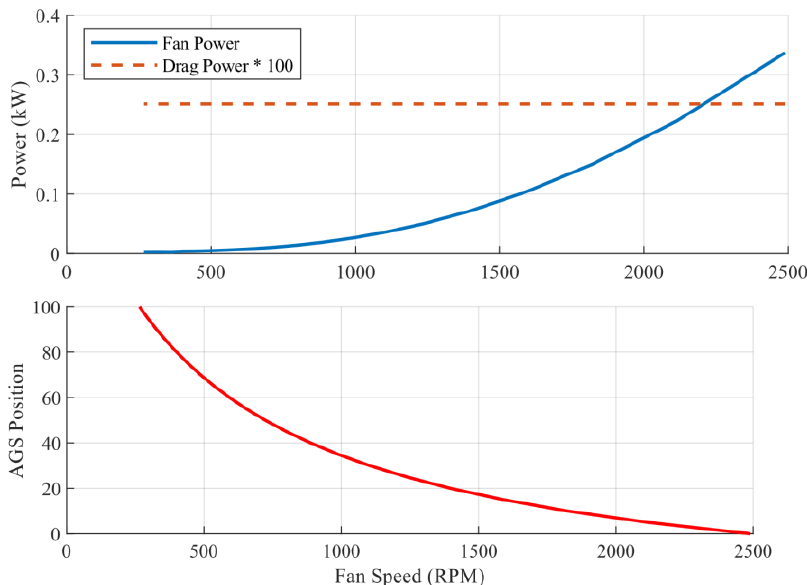
Figure 9. AGS position, fan speed, and power for 450 cfm airflow at 13.4 m/s vehicle speed.